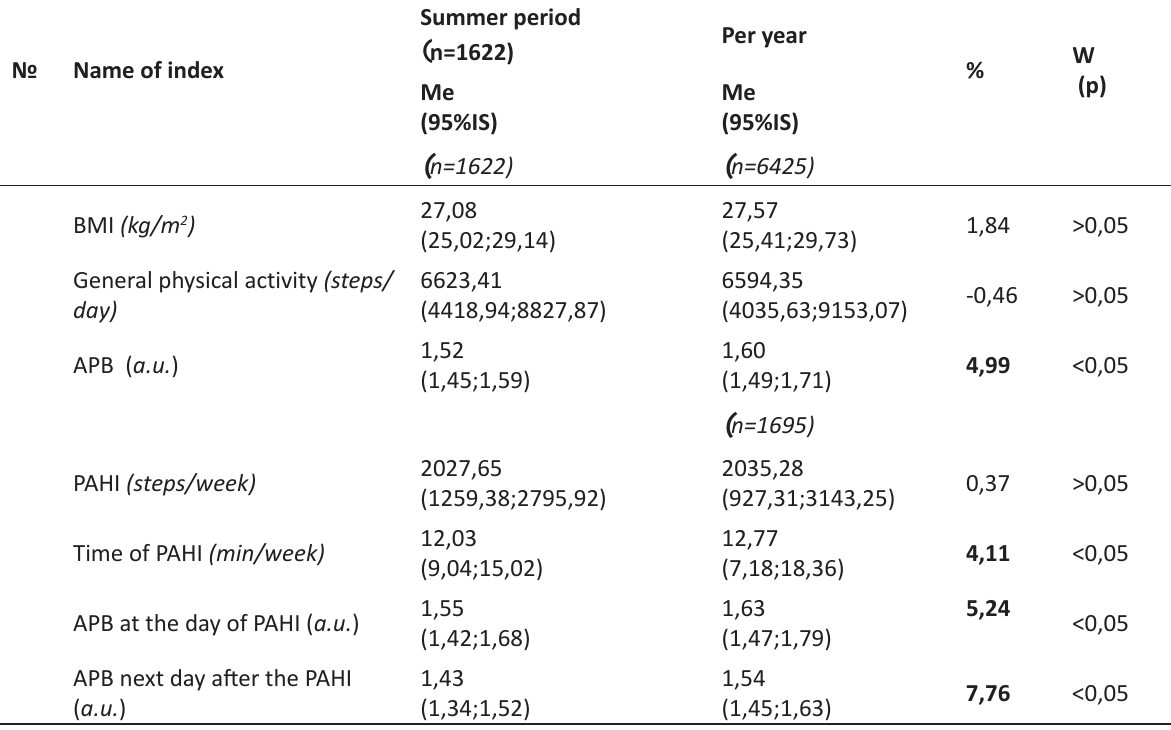
Table 3. Comparison of indicators of physical condition and physical activity of men in summer